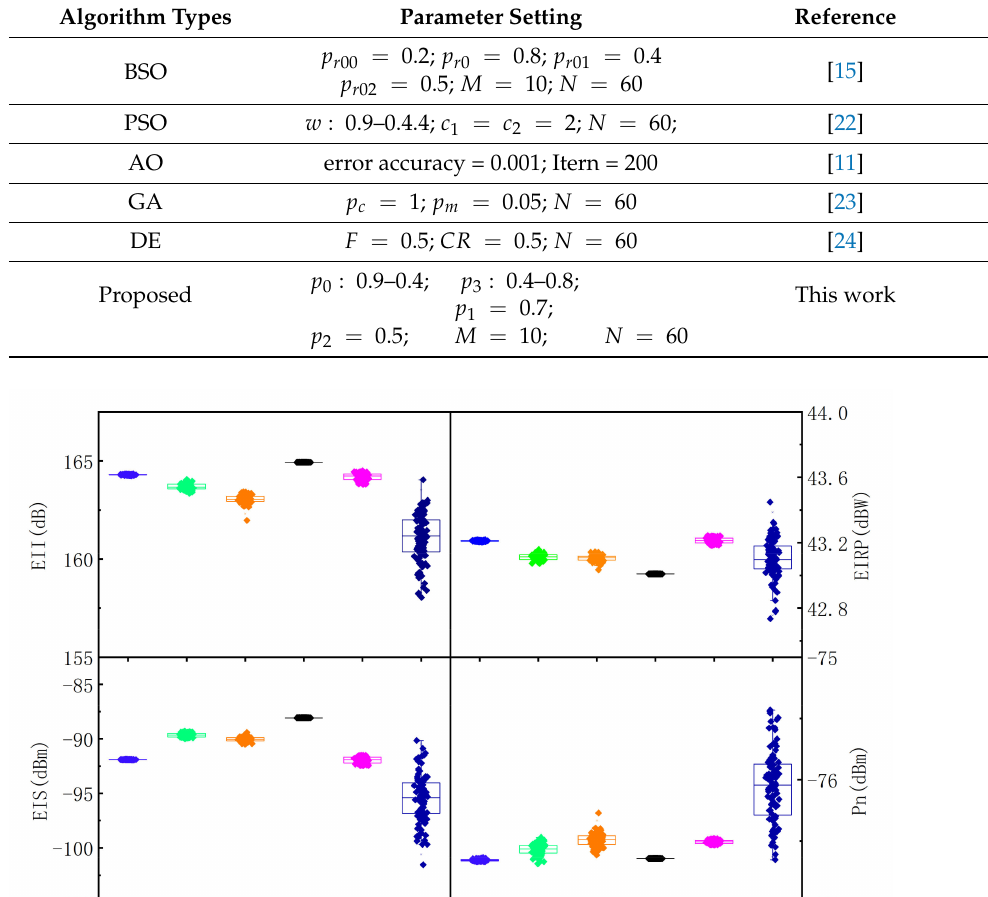
Table 1. The parameter settings of four algorithms.